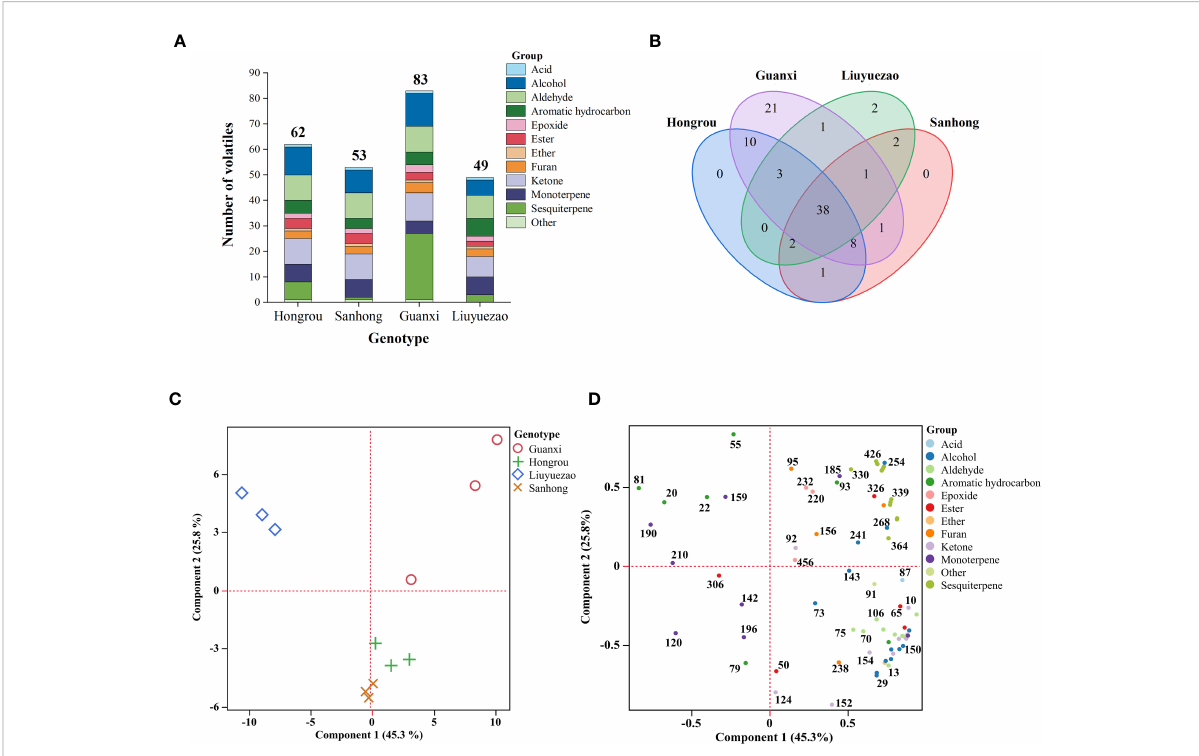
FIGURE 4 Multivariate statistical analysis of volatile pro fi les in pulp samples from the four pummelo cultivars. (A) Number of pulp volatile compounds in each chemical class. (B) Venn diagram analysis of pulp volatile compounds. (C) The score and (D) loading plots of principal component analysis using pulp volatiles from the four pummelo cultivars.The numbers can be found in the fi rst column (volatile code) in Table 3.